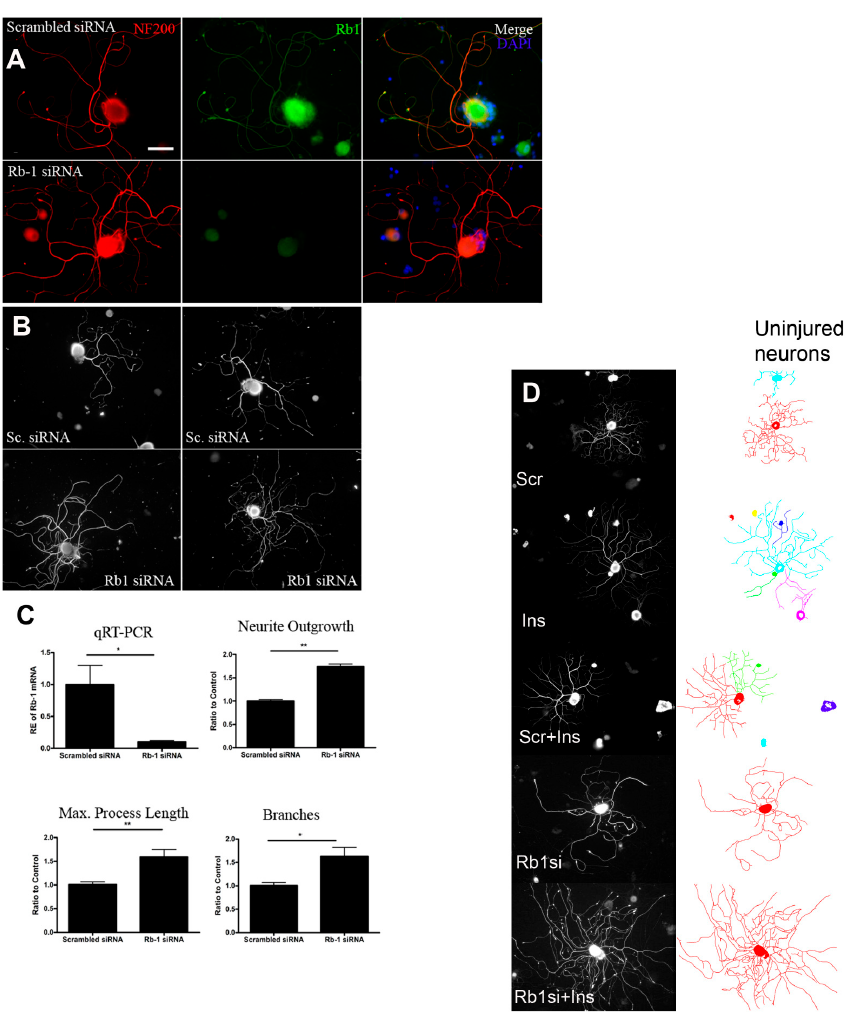
Figure 5. Rb1 is co-expressed with NF200 in injured and dissociated adult DRG neurons ( A , B ) and its knockdown by siRNA decreases Rb1 expression compared to a scrambled control siRNA. Rb1 siRNA is associated with rises in normalized neurite outgrowth of adult sensory neurons in culture with quantitation of knockdown and of outgrowth given in ( C ). Scale bar = 50 µM. * and ** p < 0.05 and 0.01 respectively. The images ( A – C ) are reproduced with permission from Christie et al. and Springer Nature [175]. In ( D ) is illustrated a synergistic impact of neurite outgrowth in adult peripheral sensory neurons in vitro exposed to (from top down) control scrambled siRNA, insulin at 10 nM, both scrambled control siRNA and insulin or Rb1 siRNA and insulin. Compared to the scrambled control siRNA cultures, the most prominent rises were noted after both Rb1 siRNA and insulin were added together. Scale bar = 100 µ M. The Image ( C ) is reproduced with permission from Komirishetty et al. and Elsevier